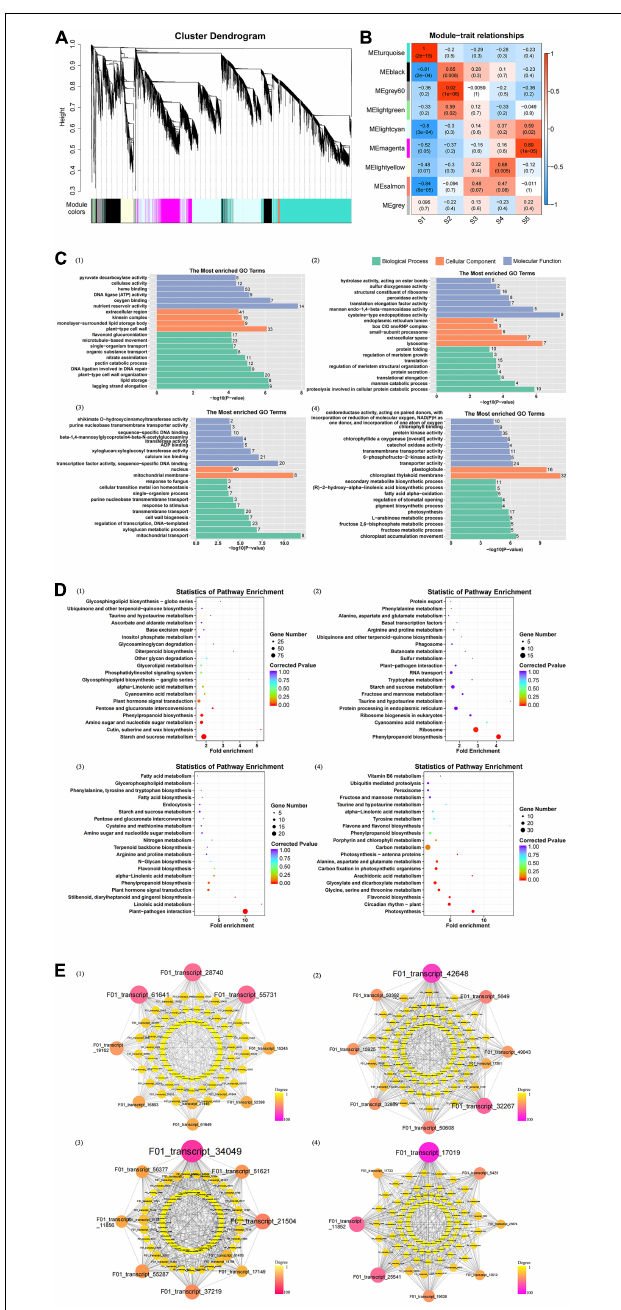
FIGURE 6 | Weighted gene co-expression network analysis (WGCNA) model of differentially expressed genes. (A) Hierarchical cluster tree showing co-expression modules identified by WGCNA. (B) Module–germination stage relationships. The upper value in the box indicates the correlation coefficient between the module and the germination stage, and the lower value indicates the significance between the two. (C) The most enriched gene ontology terms in target modules. The figure in each bar represents the number of genes enriched on the GO term. (D) Statistics of significant enrichment of pathways in target modules. (E) Potential regulatory network of DEGs in target module. Degree indicates the number of lines owned by a node. A line connects two different genes. Note: (1–4) show the turquoise, gray60, lightyellow, and magenta modules,